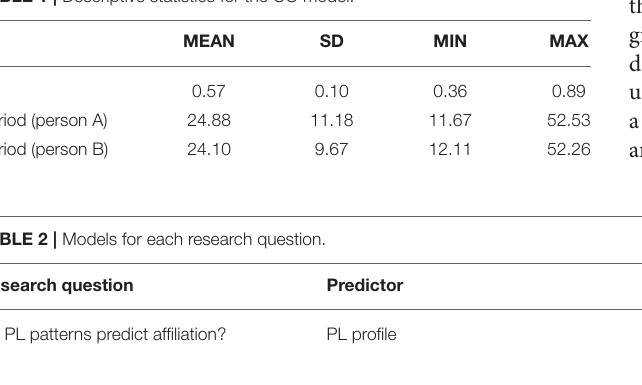
TABLE 1 | Descriptive statistics for the CO model.